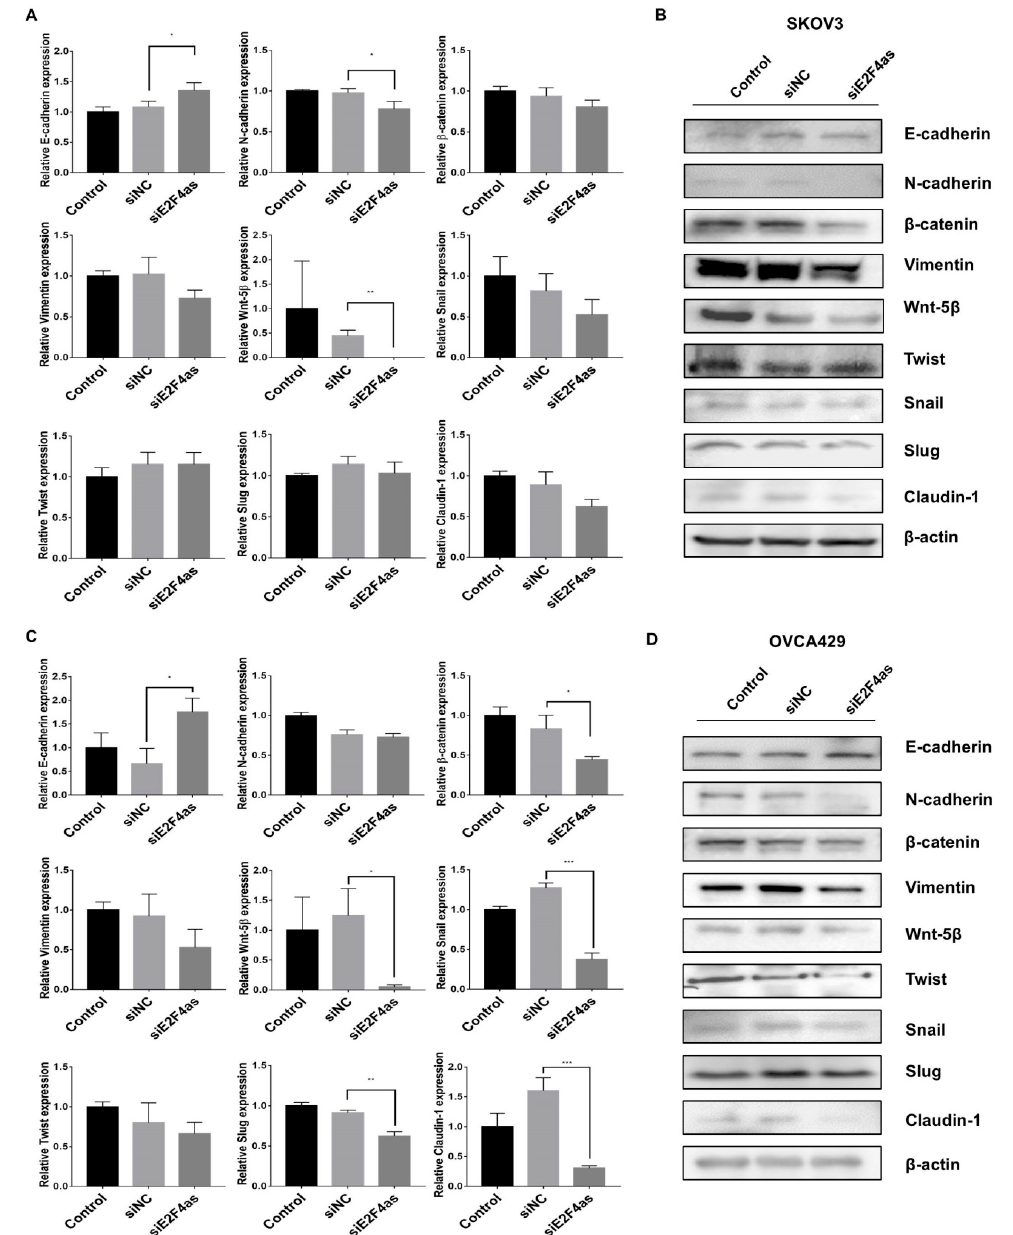
Figure 5. Effects of knockdown E2F4as on epithelial–mesenchymal metastasis (EMT)-associated genes in SKOV3 and OVCA429 cells. ( A , C ) Levels of E-cadherin, N-cadherin, β -catenin, Wnt-5 β , Twist, Snail, Slug, Vimentin, and claudin-1 analysed by qRT-PCR in SKOV3 and OVCA429 cells 24 h after transfection with E2F4as siRNA (30nM) or negative control. Data expressed as mean ± standard deviation; * p < 0.05, ** p < 0.01, *** p < 0.001 vs. siNC. ( B , D ) Protein lysates obtained from SKOV3 and OVCA429 cells 48 h after transfection with E2F4as siRNA (30nM) or negative control. Levels of E-cadherin, N-cadherin, β -catenin, Wnt-5 β , Twist, Snail, Slug, Vimentin, and claudin-1 analysed by Western blotting. Data are representative of three independent experiments.